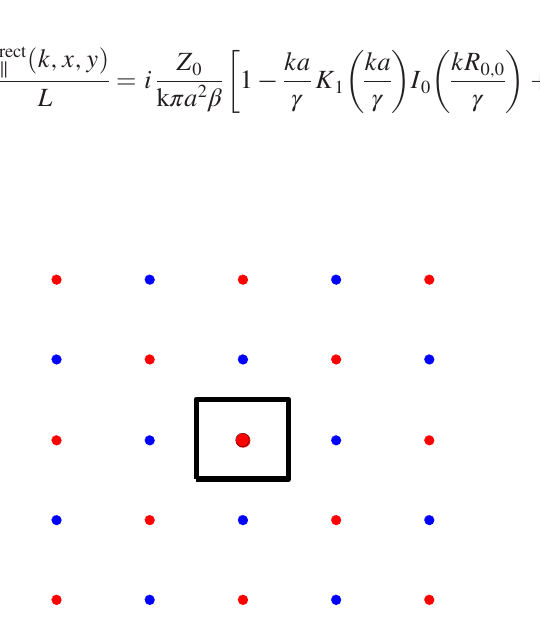
FIG. 8. 2D grid of images of a source beam centered inside a rectangular